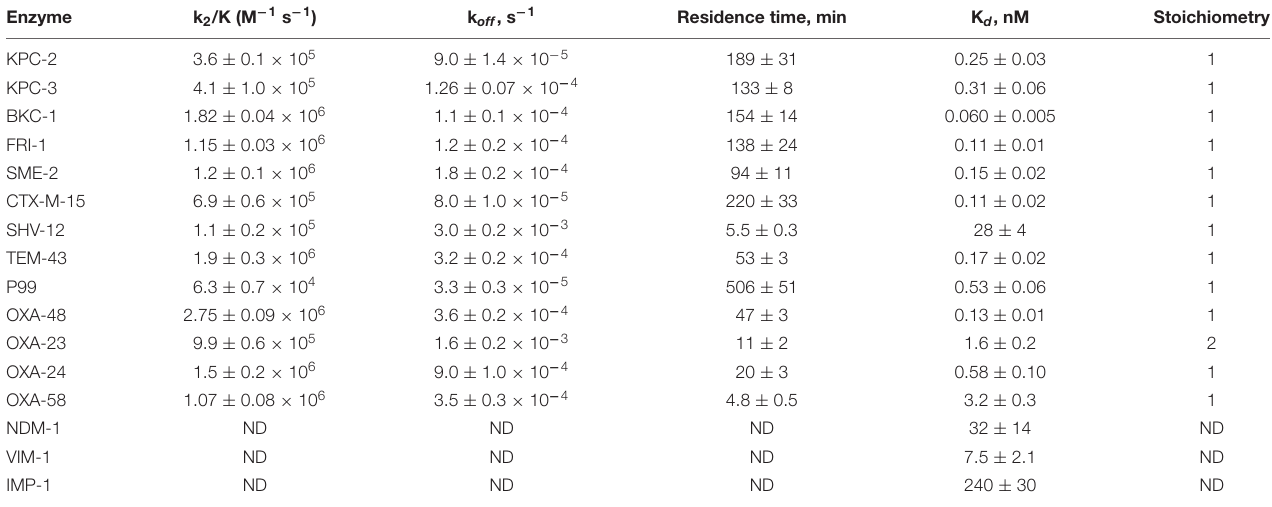
TABLE 3 | Kinetic parameters of β -lactamase inhibition by QPX7728.